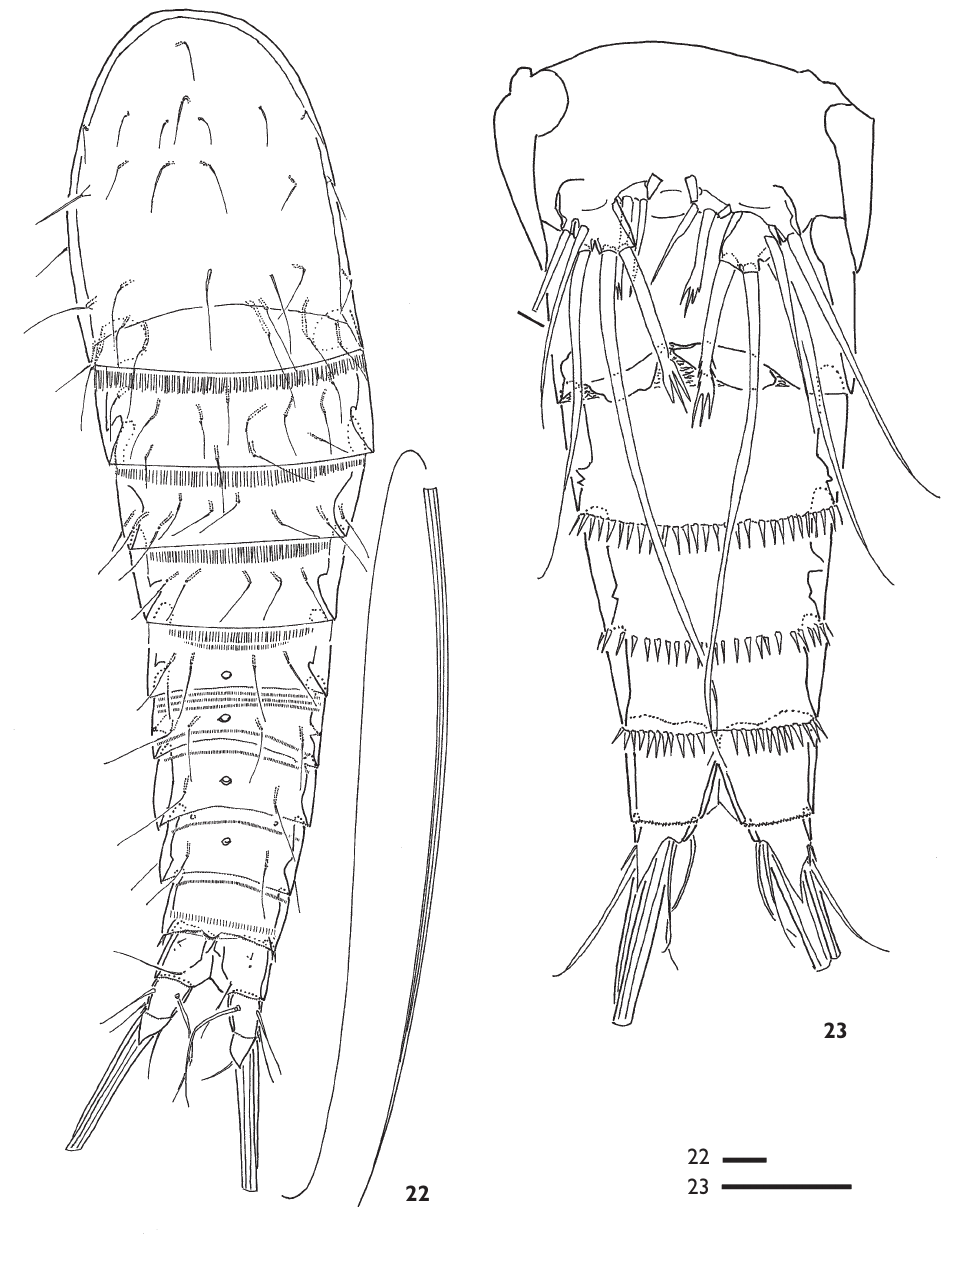
Figures 22-23. Chaulionyx paivacarvalhoi gen. et sp. n. ♂ : 22 habitus, dorsal 23 urosome, ventral. Scale bars = 10